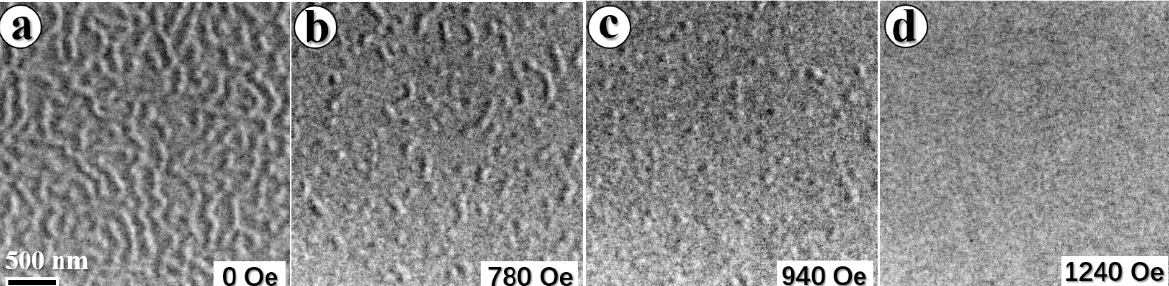
Figure 1. The magnetic domain evolution in symmetric Pt/Co(1.55)/Pt multilayers. Lorentz TEM Fresnel images showing the corresponding domain evolution at different magnetic fields ( a ) 0, (stripe phase) ( b ) 780, (mixed states) ( c ) 940, (skyrmions), and ( d ) 1240 Oe, (saturation state). The scale bar in ( a ) is 500 nm.